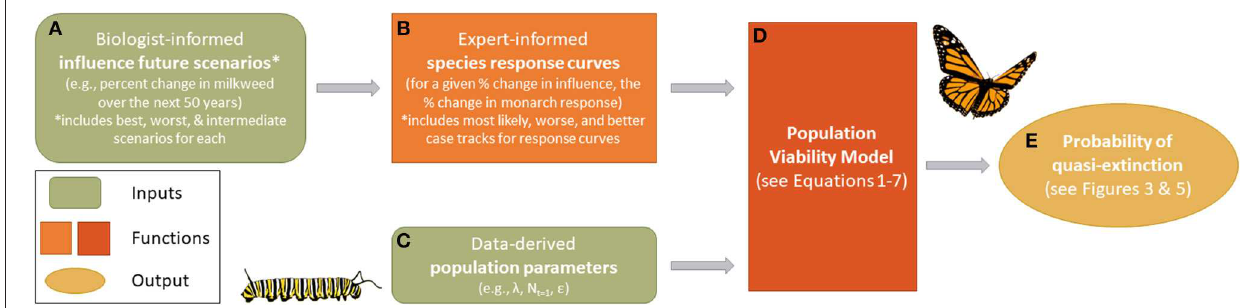
FIGURE 1 | An overview of the monarch modeling framework. Biologist-informed scenarios (A) represent percent change in a given influence over the next 50 years and include best, worst, and intermediate scenarios for each. Expert-elicited population response curves (B) specific to each influence provide the proportional change in monarch response given a proportional change in the influence (including most likely, reasonable best, and reasonable worse case responses from experts). Population response curves differ by influence and region (Eastern and Western population). Population demographic data (C) were sourced from existing literature and used to initialize the model (D) , which also received inputs from (B) . Simulation outputs from the population viability analysis were compared against a range of quasi-extinction values (E) to estimate the cumulative probability of extinction in 50 years.